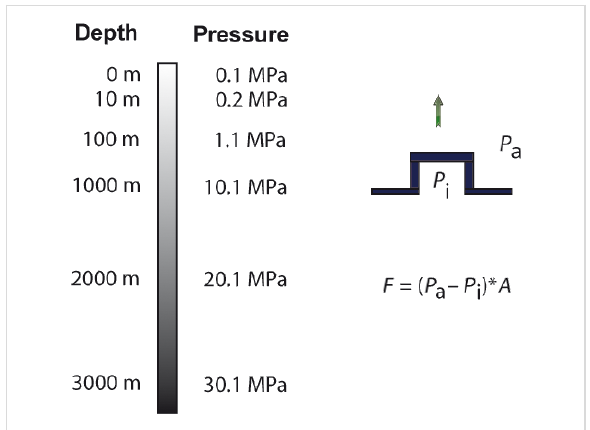
Figure 9: The pressure difference of the cavity under the suction cup and its environment determines the maximal possible suction force. As the pressure increases with water depth the theoretically maximal possible suction force increases with water depth as